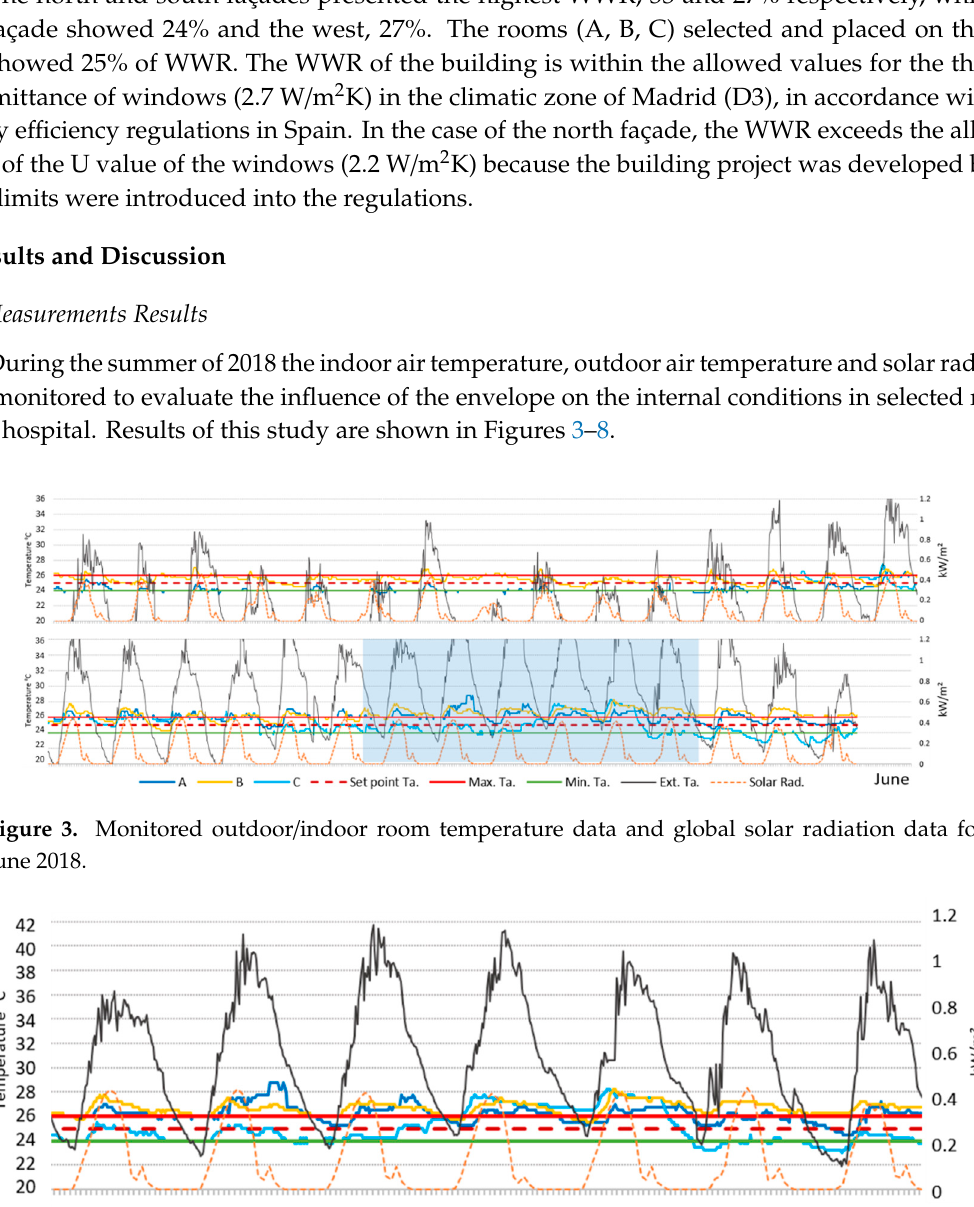
Figure 5. Monitored outdoor/indoor room temperature data and global solar radiation data for July 2018. Figure 6. Monitored data collected for rooms during the selected week, July 25th to 31st. Figure 7. Interior and exterior temperature data and global solar radiation data for August 2018.